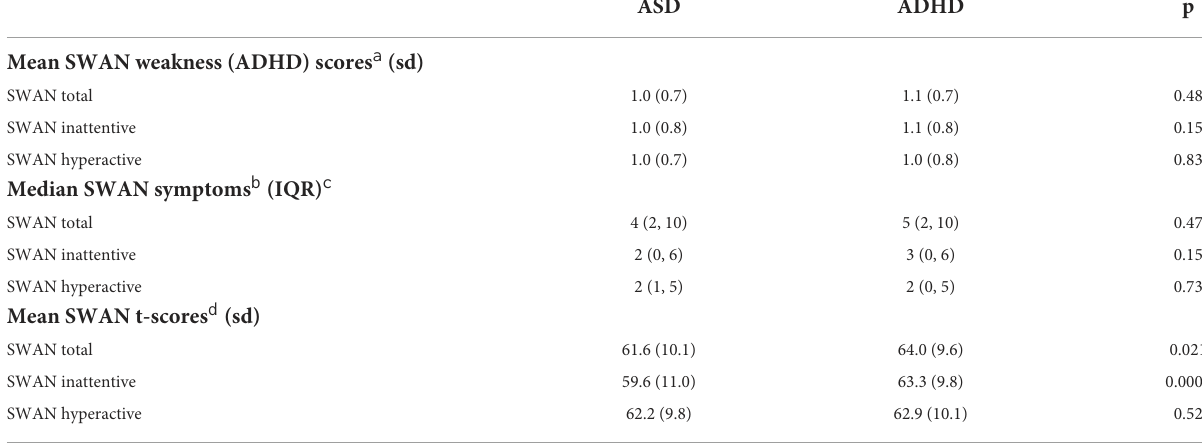
TABLE 1 Comparison of SWAN weakness, symptom, and total t-scores between the ADHD and ASD groups. Mean SWAN weakness (ADHD) scores a (sd)